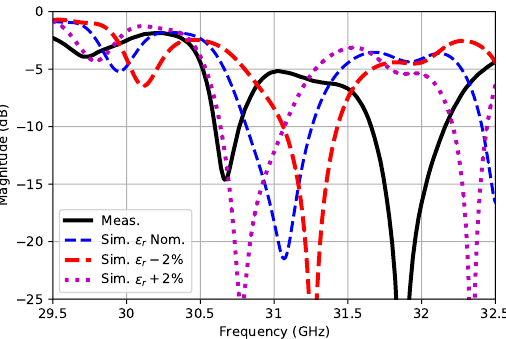
Figure 17. Measured vs. simulated S 11 for different permittivities. Figure 18 represents the simulated E-plane and H-plane radiation patterns for different permittivities at 30.5, 31 and 31.5 GHz. As can be seen, due to the ± 2% variation in the relative permittivity, some differences were observed in the radiation patterns. The strongest variations were produced for the lowest analysed frequency, i.e., 30.5 GHz, with some tilting observed and the appearance of a secondary lobe near the main one. Figure 19 represents the E-plane E θ radiation patterns measured at three different frequencies. It can be seen how those patterns corresponded approximately to those represented in Figure 18 (left column), relating again to a permittivity lower than the nominal one.